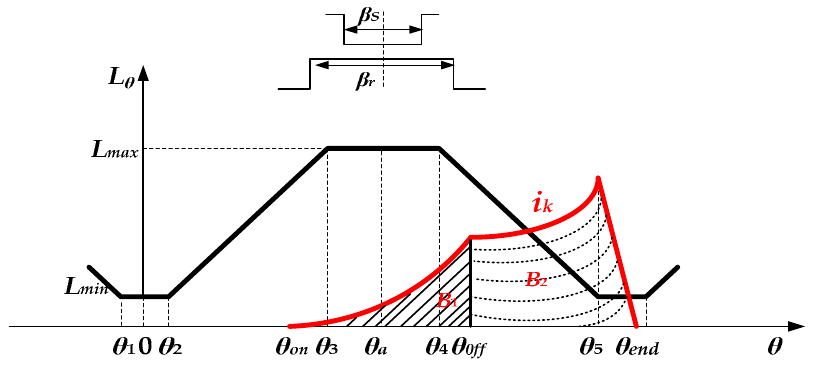
Figure 7. The schematic diagram of ɛ .